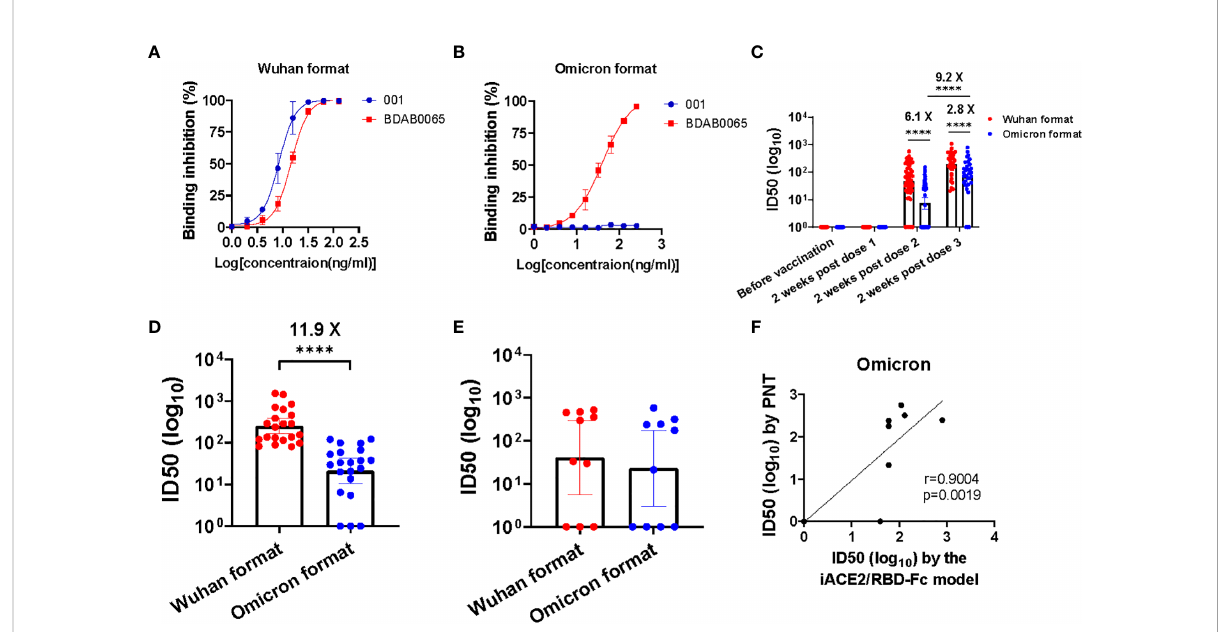
FIGURE 7 Assessment of the iACE2/RBD-Fc model in detection of omicron variant speci fi c nAb. Detection of one SARS-CoV-2 Wuhan strain speci fi c nAb 001 and one SARS-CoV-2 broadly nAb BDAB0065 by the iACE2/RBD-Fc model was shown in (A) (the format with Wuhan strain RBD-Fc, in short as Wuhan format) and (B) (the format with omicron BA,1 variant RBD-Fc, in short as omicron format). ID50 values of serum samples collected from the SARS-CoV-2 vaccine recipients at time points of before vaccination (n=60), 2 weeks post the fi rst dose (n=60), 2 weeks post the second dose (n=60) and 2 weeks post the third dose (n=34) during the vaccination course were determined by the Wuhan format and the omicron format of iACE2/RBD-Fc model and were shown in (C) . The Wuhan format and the omicron format of iACE2/RBD-Fc model also were employed to detect plasma samples from 21 convalescent patients previously infected by SARS-CoV-2 Wuhan strain and10 patients breakthrough-infected by SARS-CoV-2 omicron BA.1 variant, the determined ID50 values of each group were shown in (D, E) , respectively. To assess the accuracy of the omicron format of iACE2/RBD-Fc model, the ID50 values of 10 breakthrough infection plasma samples (the identical samples shown in Panel E ) were determined by PNT using omicron BA.1 variant pseudovirus. Correlation of ID50 values of the 10 samples determined by the PNT using omicron pseudovirus and the omicron format of iACE2/RBD-Fc model was shown in (F) . In the (C – E) , geometric mean and 95% con fi dence interval of ID50 values of the indicated group samples was shown. P values <0.0001 is represented as